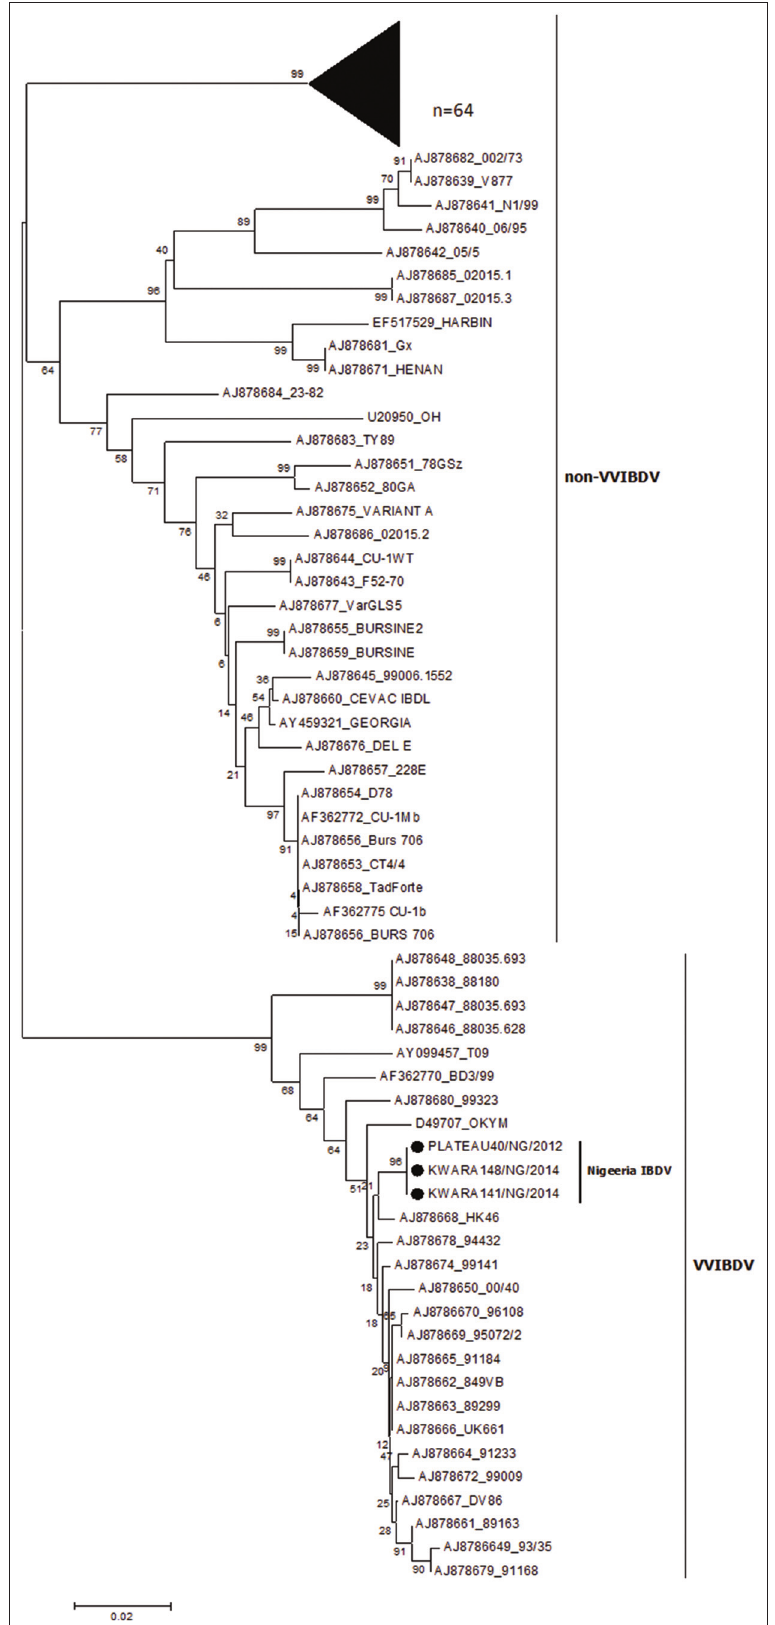
Figure-4: Phylogenetic analysis of the VP1 nucleotide sequences of Nigerian infectious bursal disease virus (IBDVs) and some IBDV VP1sequences from Genbank using the neighbor joining method with 1000 bootstrap replication. Phylogenetic analyses based on the hvVP2 Nigerian viruses belong to the vvIBDV group; only amino acids (Figure-2) suggest that most of the one virus was found in the non-vvIBDV cluster.